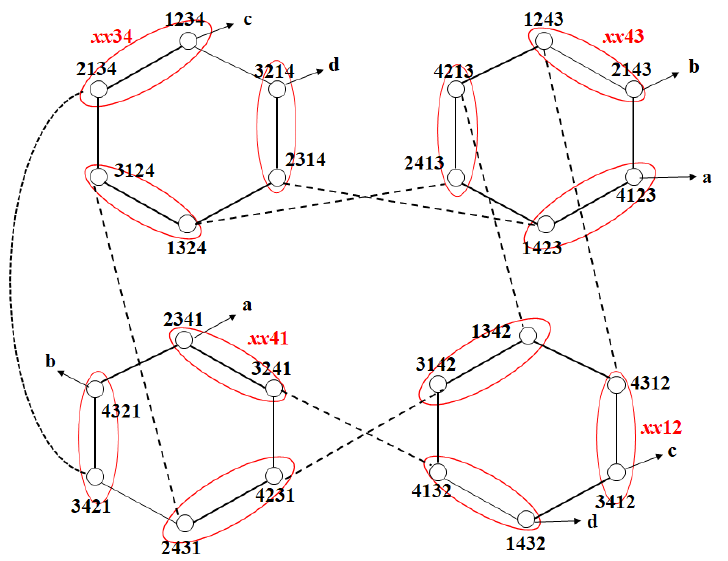
Figure 2. Subgraphs of LS 4 .